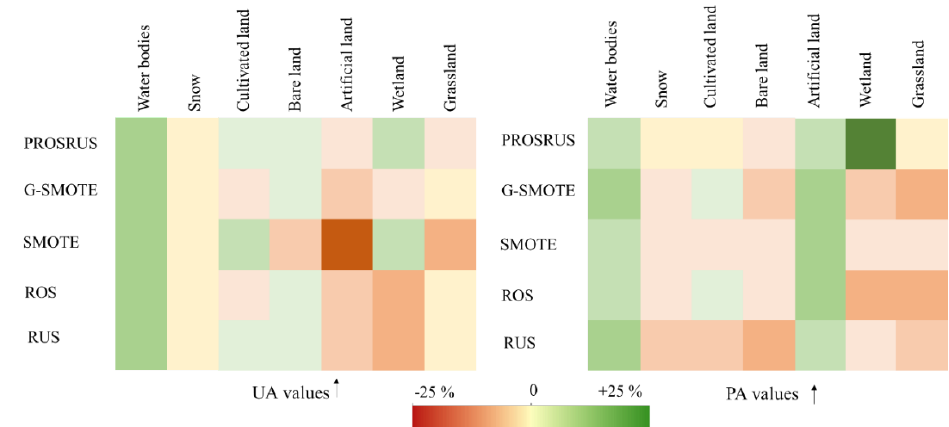
Figure 11. Effects (increase or decrease) of different balancing methods on the UA and PA values of Figure 11. E ff ects (increase or decrease) of di ff erent balancing methods on the UA and PA values of various classes in Site-3. Refer to Appendix E for more information various classes in Site-3. Refer to Appendix E for more